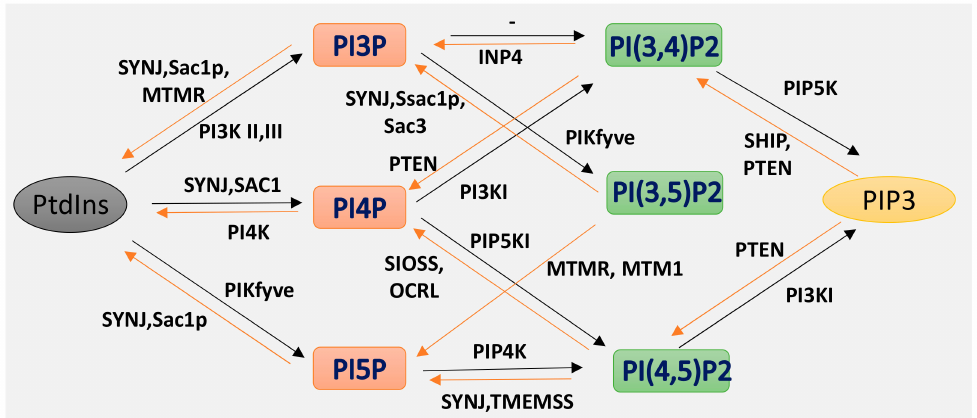
Figure 1. Isoforms of phosphoinositides. By the action of PIK and phosphatase, phosphatidylinositol (PtdIns) and the three isoforms of PIP2 are formed, as indicated here. The specific action of PI3K I, II III and of the 3-phosphatases are also